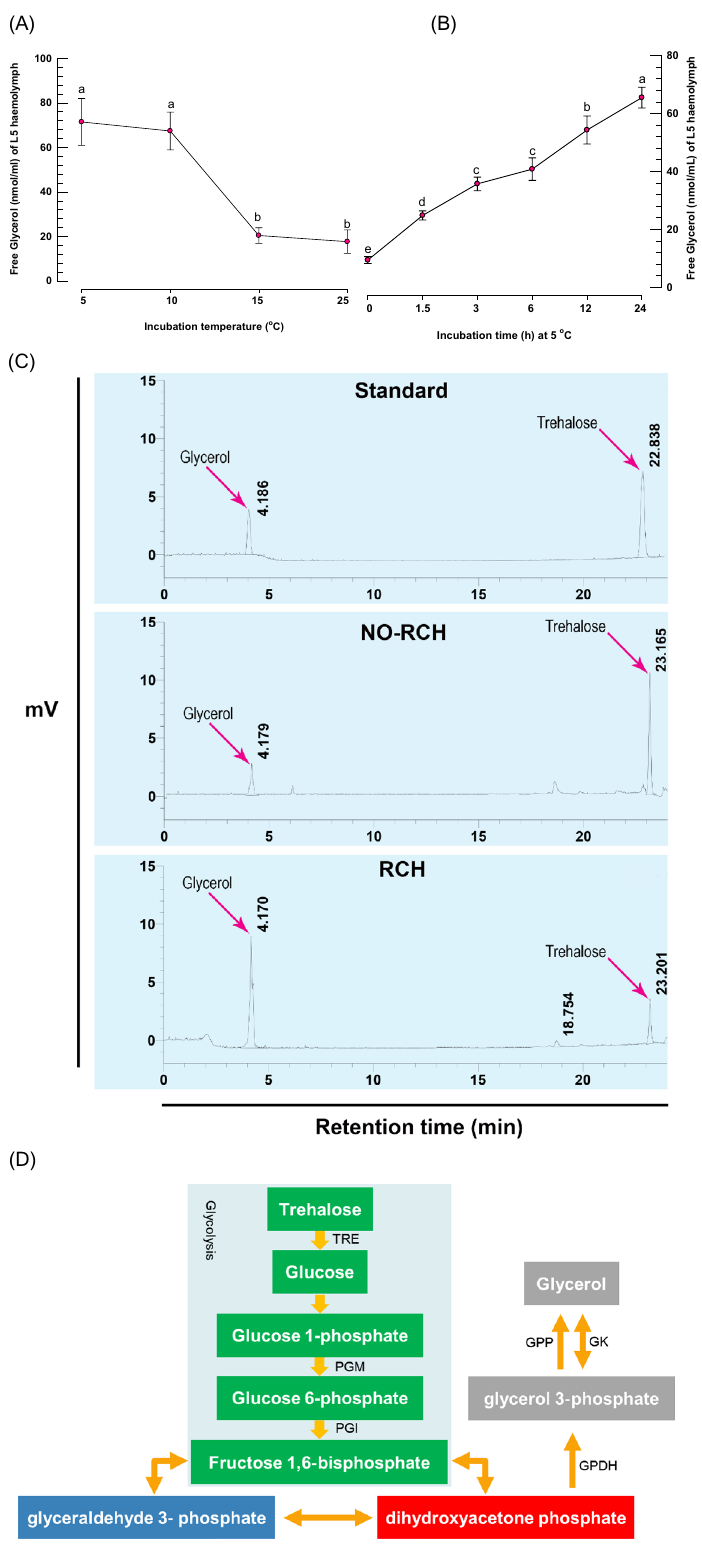
Figure 1. Measurement of free glycerol in plasma of L5 of Spodoptera frugiperda ( A ) at different temperature when the larvae incubated for 24 h. ( B ) Effect of exposure time on glycerol content of plasma when the larvae were incubated at 10 °C. Each treatment was replicated three times with 10 larvae per replication. Different letters indicate significant differences among means at (Type I error = 0.05, LSD test). ( C ) Chromatograms of hemolymph extracted from larvae exposed to 5 °C for 24 h. ( D ) A putative glycerol production pathway. Glycerol is formed by catabolizing glucose to dihydroxyacetone-3- phosphate (DHAP), which is then reduced to glycerol-3-phosphate (G3P). TRE, PGM, PGI, and GPP represent for trehalase, phosphoglucomutase, phosphoglucoisomerase, and glycerol ‐ 3 ‐ phosphate phosphatase,